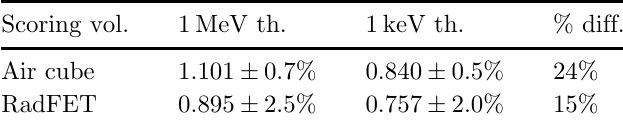
Table 2. Dose in 10 (cid:4) 14 Gy/pot deposited within the air rack and the RadFET gate oxide in SiO (with NEDEFA defaults) and 1 keV (using PRECISIO defaults) energy